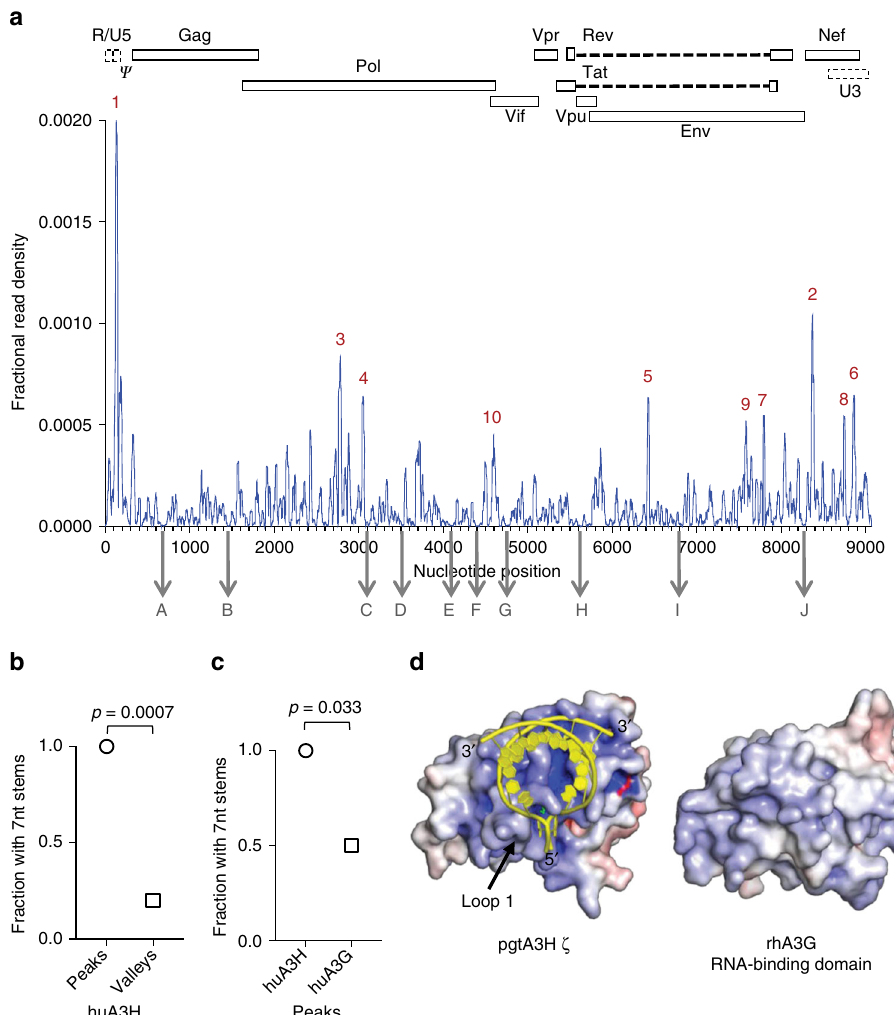
Fig. 5 Analysis of A3H binding to the HIV-1 genome. a Frequency distribution of nucleotide occurrence (read density) relative to the sum of read densities in reads mapped to the HIV-1 NL4-3 genome in a huA3H CLIP-Seq experiment using HIV-1 particles 8 . The 10 most frequently (designated 1 – 10 for highest to lowest fractional read density) and 10 least frequently bound sites (designated A – J for relative position in the viral genome) are indicated. A schematic diagram of the HIV-1 genome is shown above. b Frequency with which ≥ 7-nt duplexes are predicted to occur within 101-nt RNA elements containing the 10 sites with high-frequency binding (peaks 1 – 10), and 101-nt elements with low-frequency binding (valleys A – J). c Frequency with which ≥ 7-nt duplexes are predicted to occur within 101-nt RNA elements containing the 10 sites most frequently bound by A3H and A3G. d Comparison of surface charge distribution for A3H and the A3G RNA-binding domain. RNA (yellow cartoon) binds to the most positively charged surface of A3H (electrostatic surface potential colored from red to blue, − 10 to +10 kT/e). The analogous surface of the A3G RNA-binding domain (PDB 5K81 22 ) is relatively Expression of A3H protein variants . Recombinant huA3H, three pgtA3H var- iants ( α , η , ζ ), and catalytically inactive pgtA3H α E56A 13 were produced in E. coli using codon-optimized synthetic DNAs (Supplementary Table 1). Ligation- independent cloning (LIC) was used with the expression vectors pMCSG7 37 (N- terminal His 6 tag and tobacco etch virus (TEV) protease cleavage site), including all pgtA3H variants, or pMocr 38 (N-terminal His 6 tag, Mocr, and TEV cleavage site) for huA3H. All sequences were con fi rmed by Sanger sequencing. Plasmids phA3H001 and ppgtA3H001-003 were transformed into E. coli strain BL21(DE3) carrying the pGro7 plasmid for co-expression of chaperones GroES-GroEL (Takada) 39 . Transformed cells were grown in 4% glycerol terri fi c broth media at 37 °C until the OD 600 reached 0.6 – 0.8. Chaperone expression was induced with L - arabinose (1 g/L) at 37°C for 1h, then cultures were cooled to 20 °C, induced with 200 µ M IPTG, and grown overnight. Cells were collected via centrifugation and stored at − 20°C.